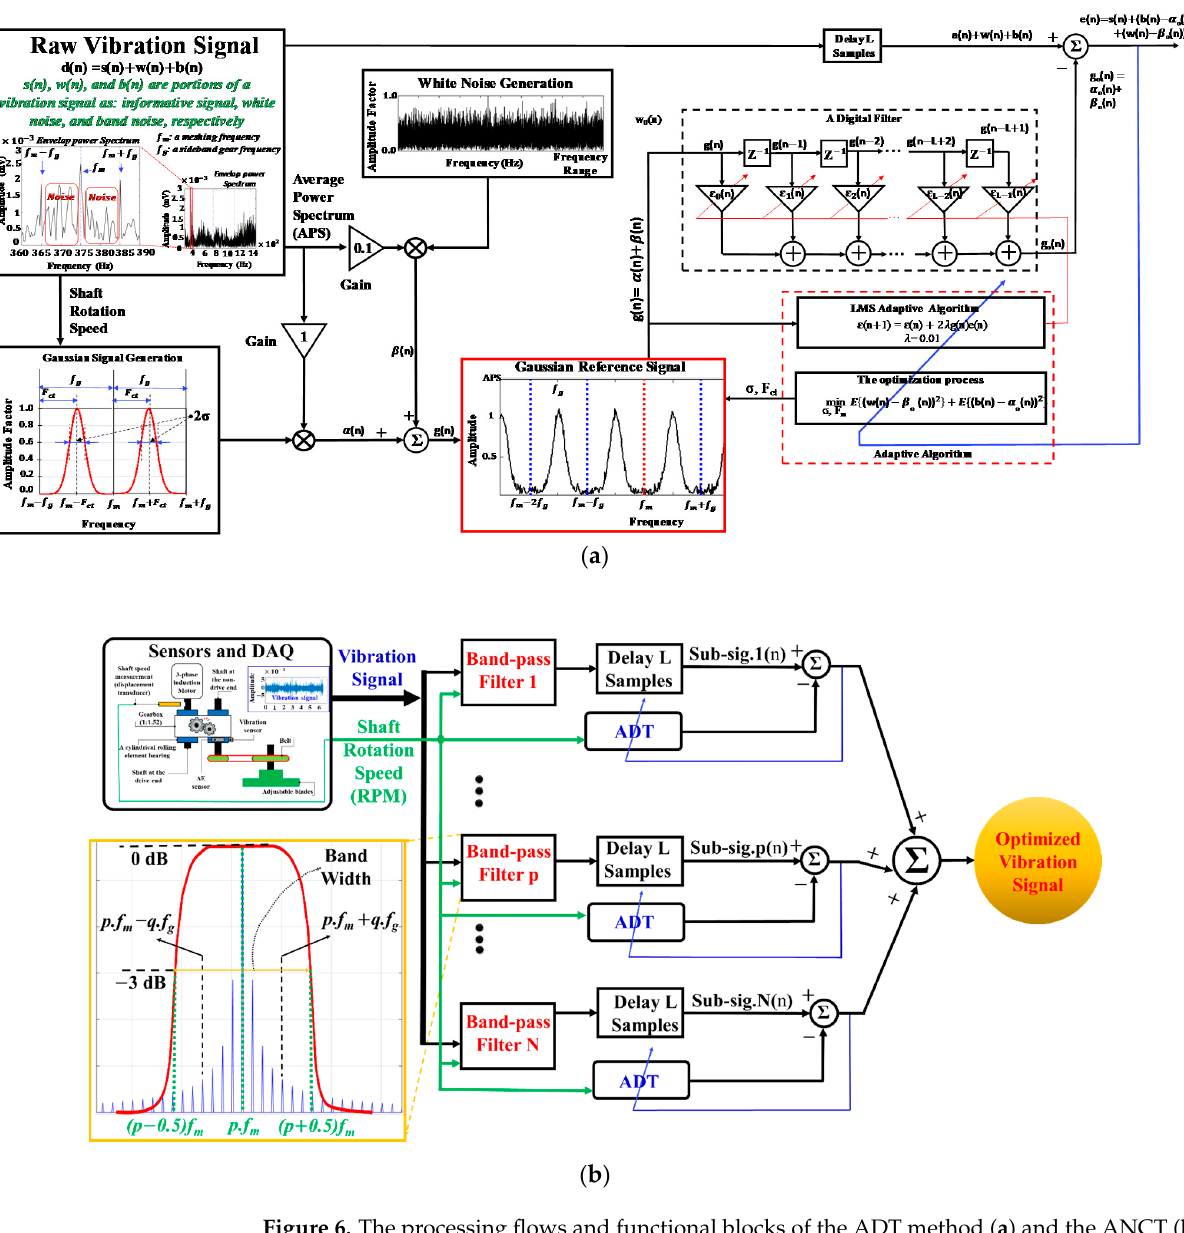
Figure 6. The processing flows and functional blocks of the ADT method ( a ) and the ANCT ( b ). Next, the LMS technique is used to adaptively adjust the parameters ( F ct , σ ) of each generated NPS in conjunction with the filter weights to achieve the optimized parameter set [18]. Figure 6a illustrates the signal processing flow and function blocks of the ADT